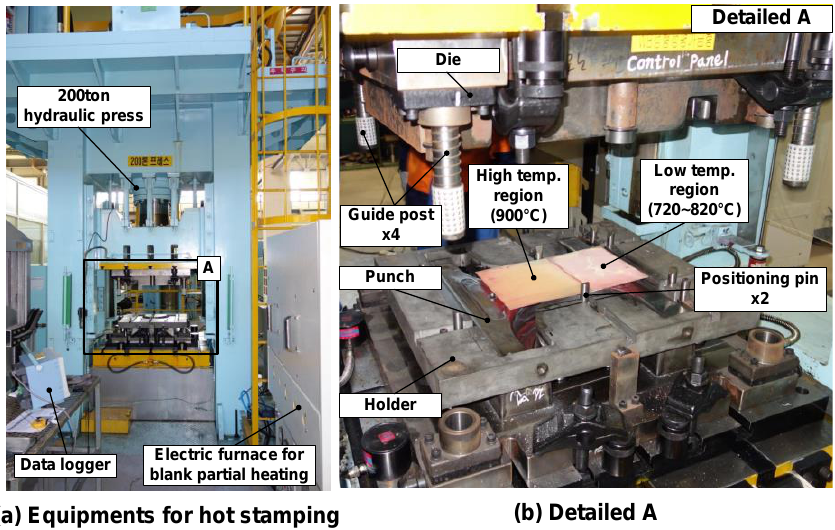
Figure 10. Experimental setup for hot stamping using local blank heating.